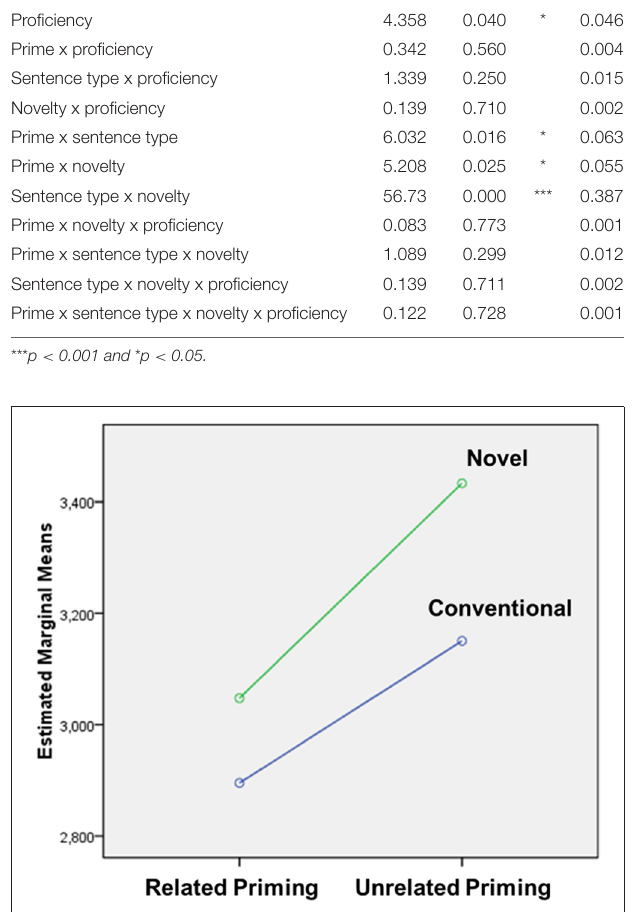
FIGURE 2 | Interaction between prime and